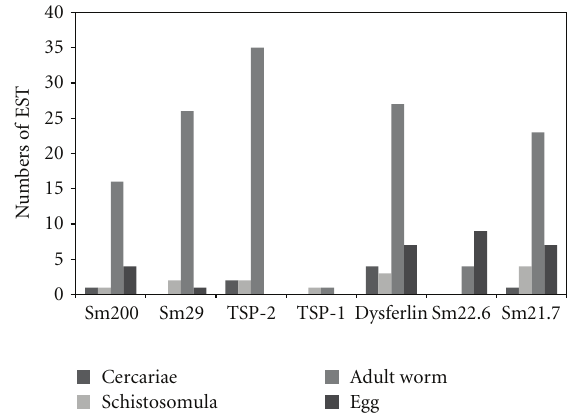
Figure 1: Predicted expression of schistosome tegument proteins in the di ff erent parasite life stage in the definitive host. schistosome tegument protein identified by proteomics analysis of the adult worm tegument was analyzed in SchistoDB database (http://www .schistodb.net/). Bars represent the numbers of EST in each parasite life stage whose annotation correspond to Sm200, Sm29, TSP-2, TSP-1, Dysferlin, Sm22.6, or